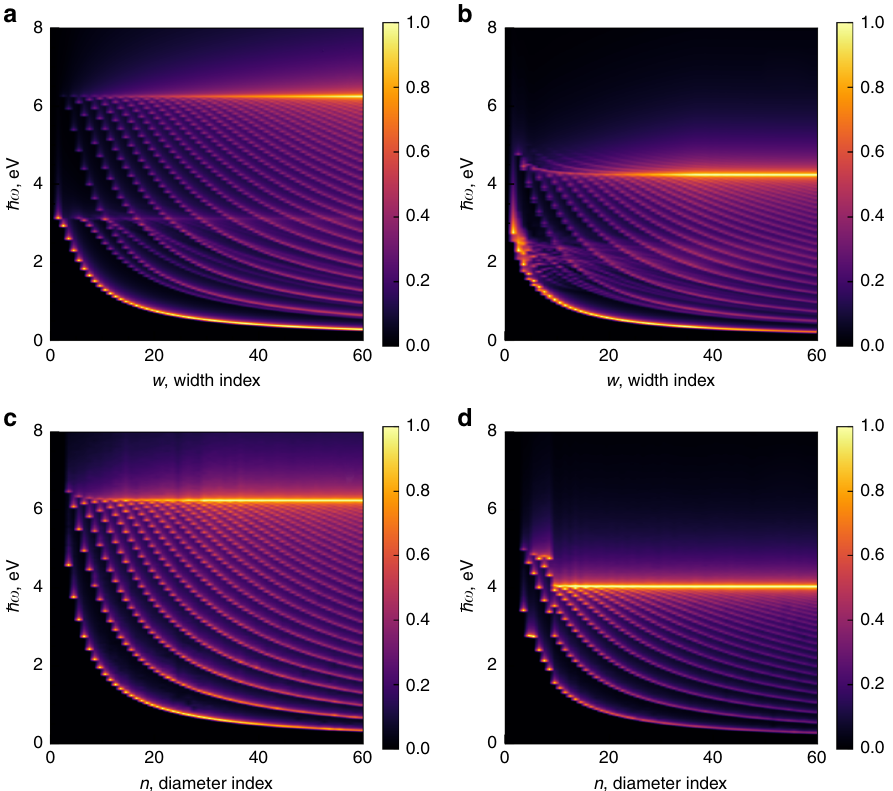
Fig. 1 Absorption intensity density plots. Optical absorption dependence on the excitation energy and transverse size of ZGNRs ( a , b ) and armchair SWCNTs ( c , d ) in various tight-binding models: a , c the nearest-neighbor tight-binding model (Partoens 2006) 55 , b model fi tted to Quantum Espresso DFT data (ZGNRs (av.)), and d model fi tted to SIESTA DFT data (Reich 2002) 60